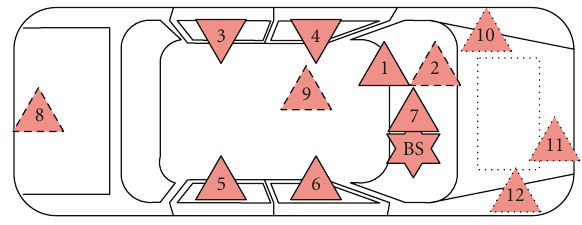
Figure 5: Test vehicle and transmission